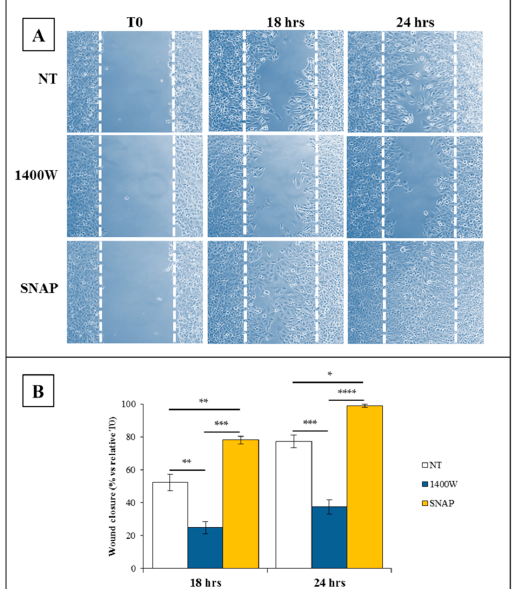
Figure 4. Involvement of NO on the scratch-wound healing ability of U-87 MG cells. ( A ) Representative microscopy images of the scratch-wound healing assay captured at 0 h, 18 h, and 24 h. Scratched U-87 MG monolayers were incubated without (not treated, NT) or with NOS2 inhibitor 1400W (100 μ M) or NO-donor SNAP (100 μ M) for the indicated times after injury (10× magnification). ( B ) The extent of the wound closure rate was calculated as described and expressed as % closure versus relative T0 at 18 h and 24 h. Data are expressed as the mean ± SEM of two independent experiments in duplicate. For a comparative analysis of groups of data, repeated measures two-way ANOVA followed by a Bonferroni post hoc test was used (* p < 0.05, ** p < 0.01 , *** p < 0.001, **** p < 0.0001).